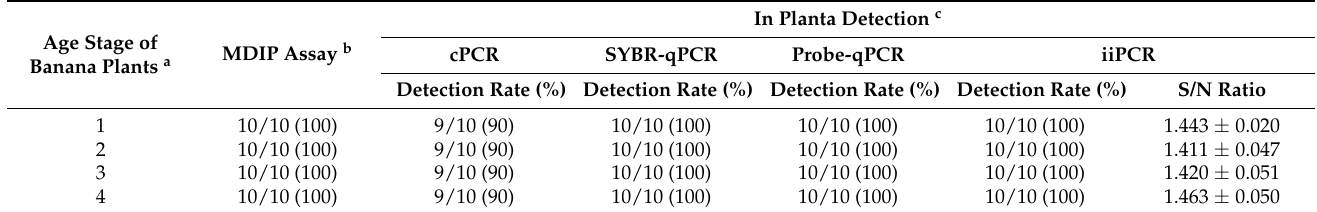
Table 4. Comparison of Fo iiPCR and molecular detection methods for field detection of Fusarium oxysporum infection of different age stages of banana plants with mild symptoms. An automated DNA extraction protocol was used.